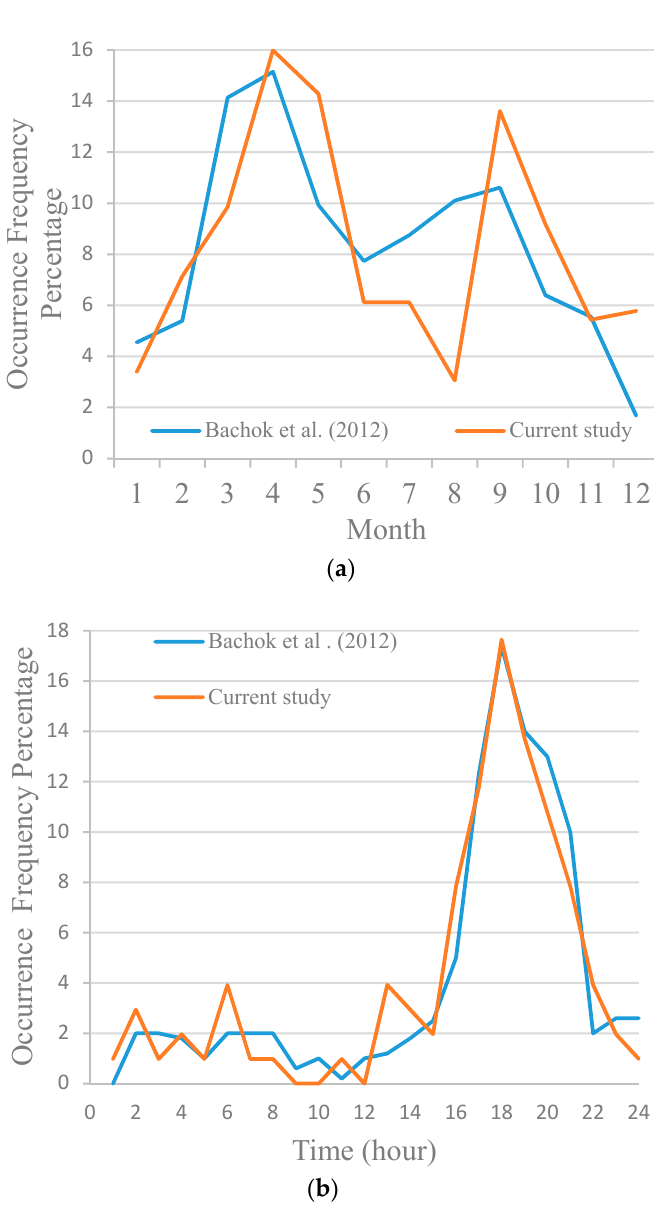
Figure 5. Validation of the occurrence frequency of windstorm damage cases according to ( a ) month; ( b ) hour.